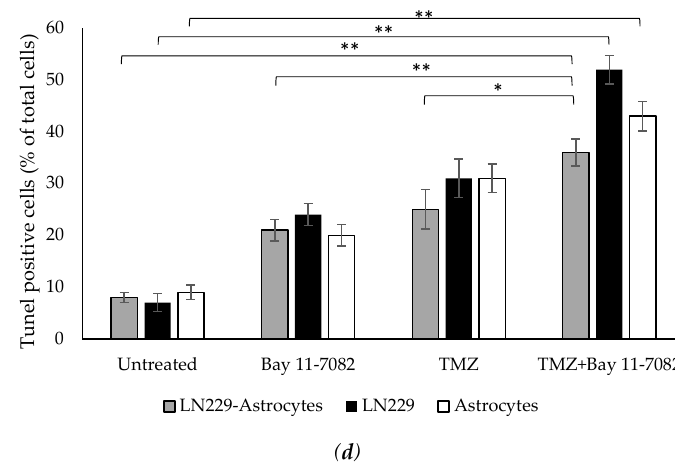
Figure 3. Fluorescent images of TUNEL ( + ) cells (green) in co-cultured and mono-cultured cells. ( a ) LN229–astrocytes co-culture. ( b ) LN229 mono-culture. ( c ) Astrocytes mono-culture. TUNEL assay was performed on cells treated with TMZ and / or Bay 11-7082 in the microwells. Cells were collected from the microwells, trypsinized, and re-plated into 8-well chamber slides. Nuclei were counterstained with DAPI (blue). ( d ) Numbers of TUNEL ( + ) cells are presented as mean ± SD of three biological replicates. * indicates p < 0.05, ** indicates p < 0.01. X20 objective. Scale bars, 100 µ m.